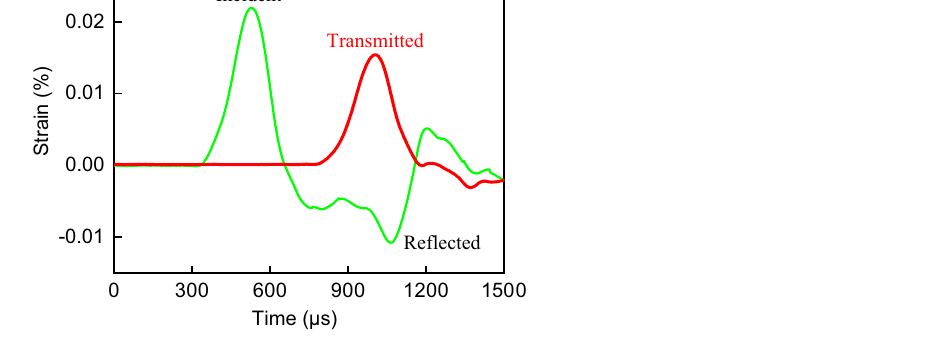
Figure 4. Incident, reflected and transmitted